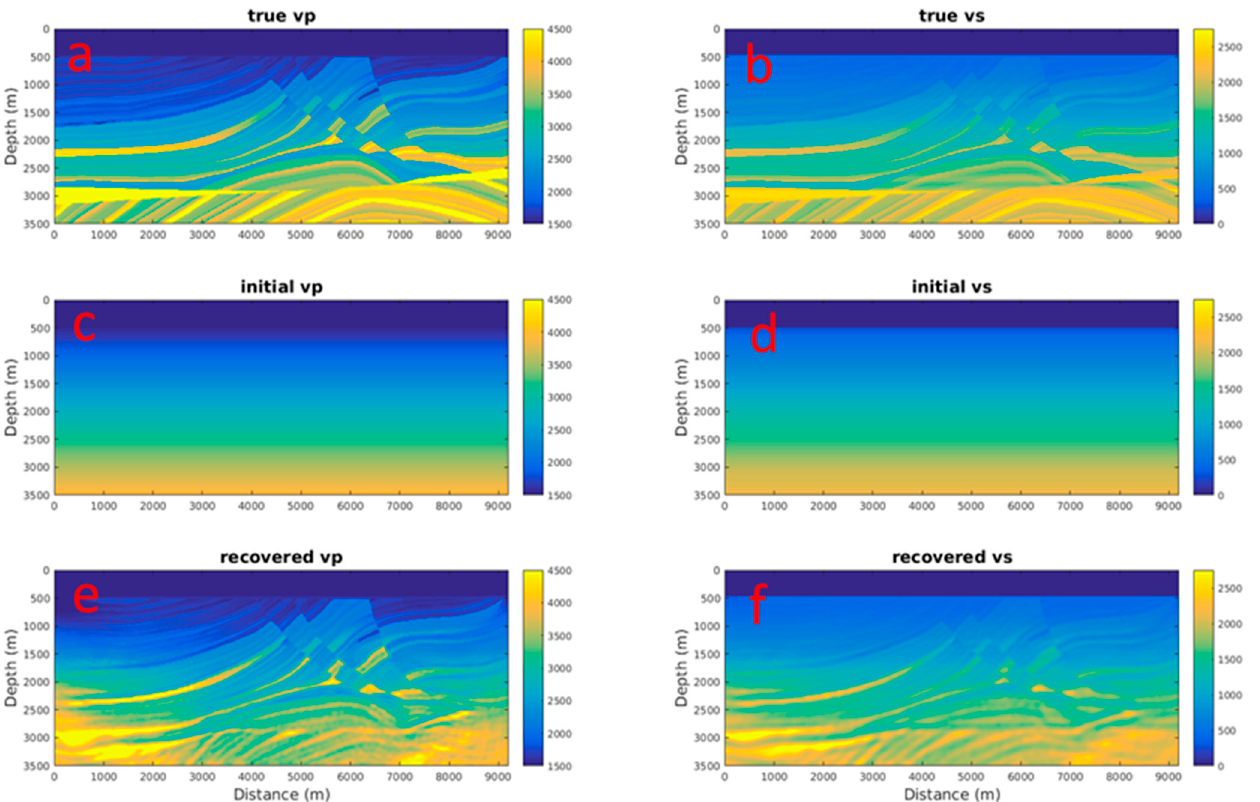
Figure 10. The true Marmousi2 V p -velocity ( a ) and V s -velocity ( b ); the starting V p model ( c ) and V s model ( d ); the DSR FWI inversion results for V p ( e ) and V s ( f ).